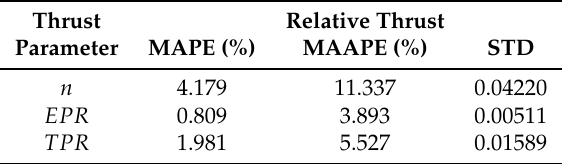
Table 4. Different error terms of thrust rise in contrast to linear change when using different thrust parameters.